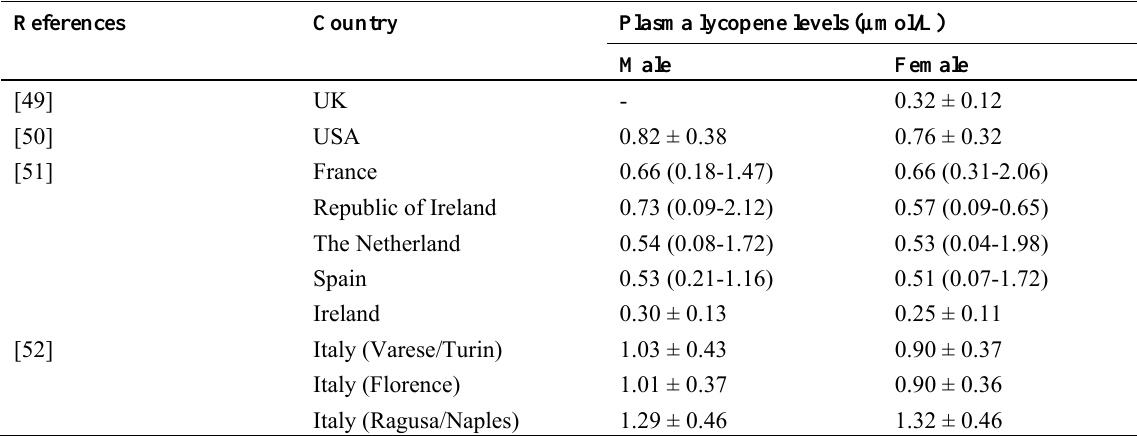
Table 2. Plasma lycopene levels in people from different